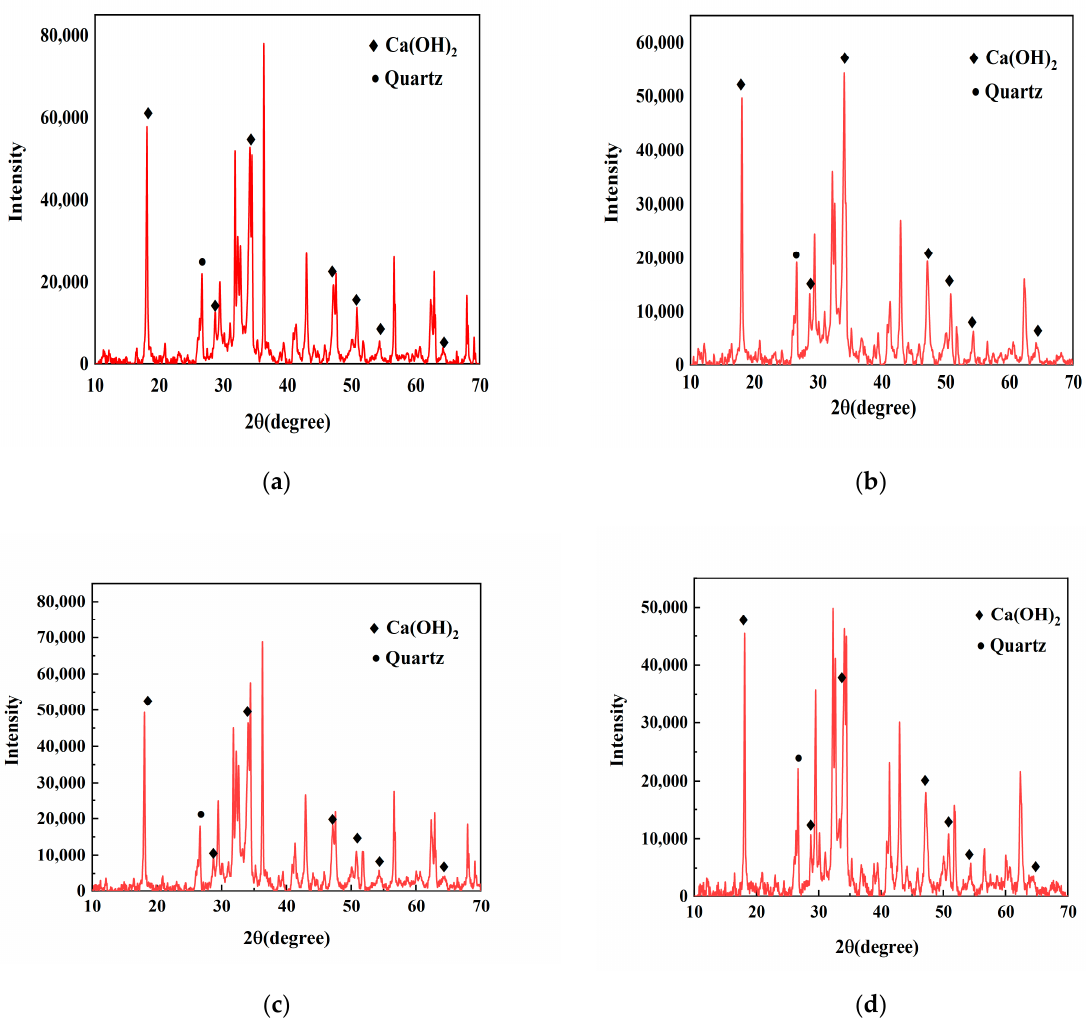
Figure 5. XRD pattern of cement slurry, where ( a ) is blank reference group; ( b ) the hydration temperature rise inhibitor group containing 0.5%SBT; ( c ) is the dosage of 1.0%SBT hydration temperature rise inhibitor group; ( d ) is the dosage of 1.5%SBT hydration temperature rise inhibitor group.